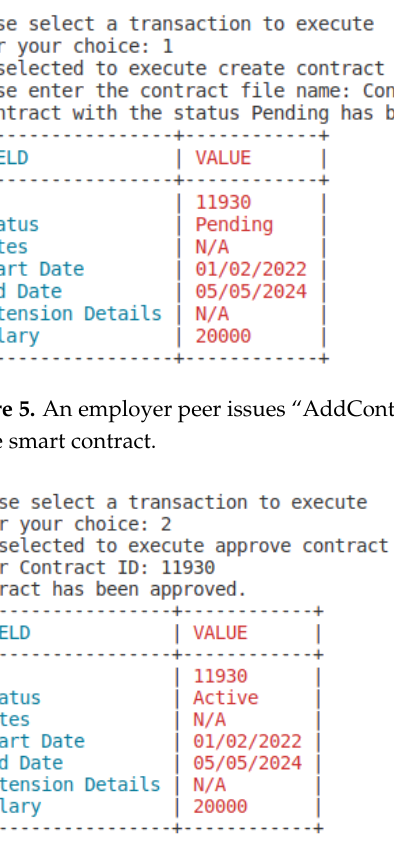
Figure 6. An employee peer issues “ApproveContract” to approve the employment contract issued by the